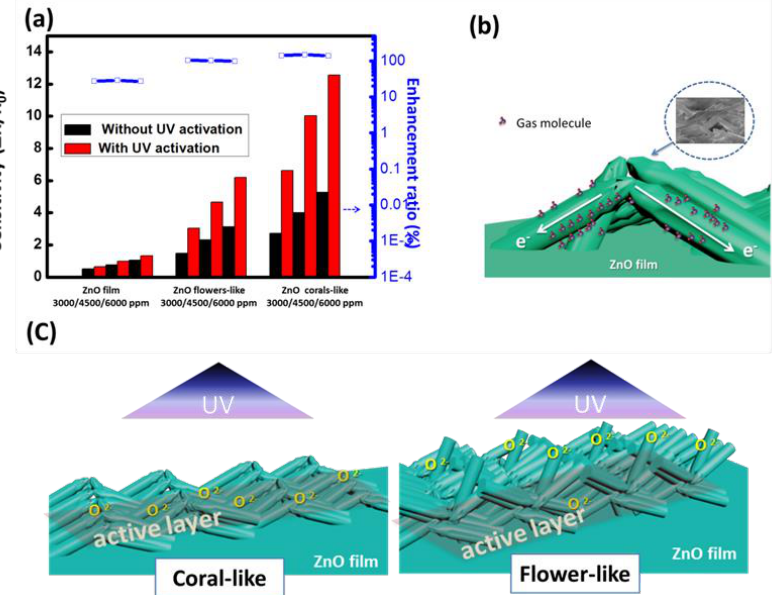
Figure 9. ( a ) Sensitivity and enhancement ratio of the detector to toluene. ( b ) Schematic illustration of ZnO-nanowire bridges over the ZnO film. The inset in the upper-right corner is the real SEM image. ( c ) Simple model for ZnO flower-like and coral-like detectors with 2 μW/cm 2 UV illumination; the rectangle shows the effective active layer for gas sensing.